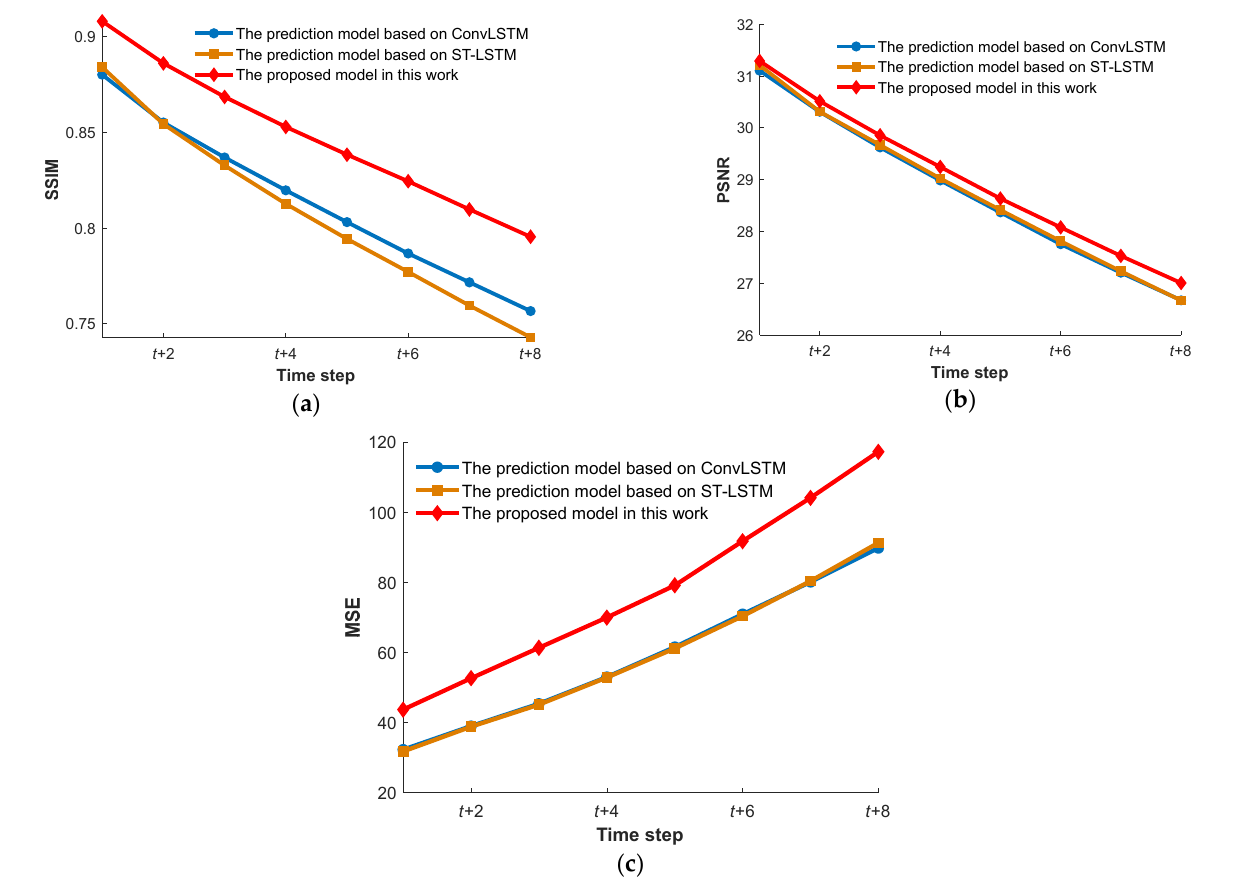
Figure 13. Comparison of evaluation results (MSE ( a ), PSNR ( b ), and SSIM ( c )) between the proposed prediction model and the existing models tested on the Panicoid Phenomap-1 dataset.